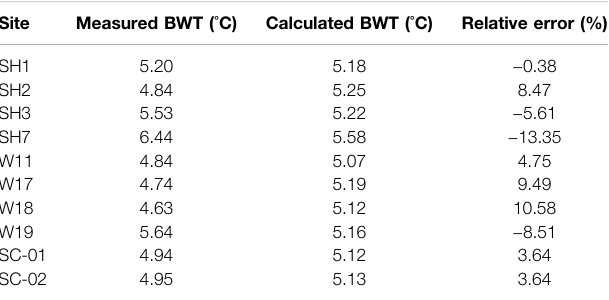
TABLE 1 | Calculation parameters of the BWT (Zhu et al., 2013; Zhang et al., 2020a; Zhang et al.,